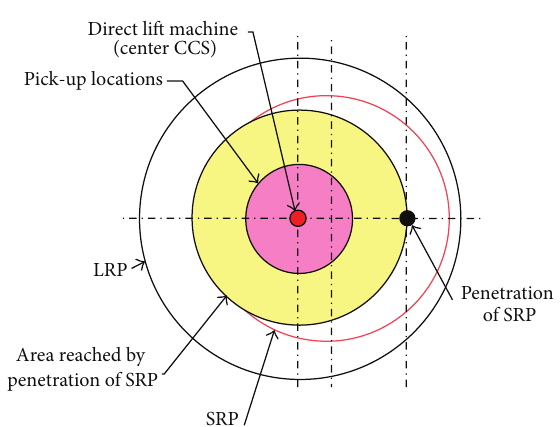
Figure 14: Retention of the direct lift machine at the centre of the